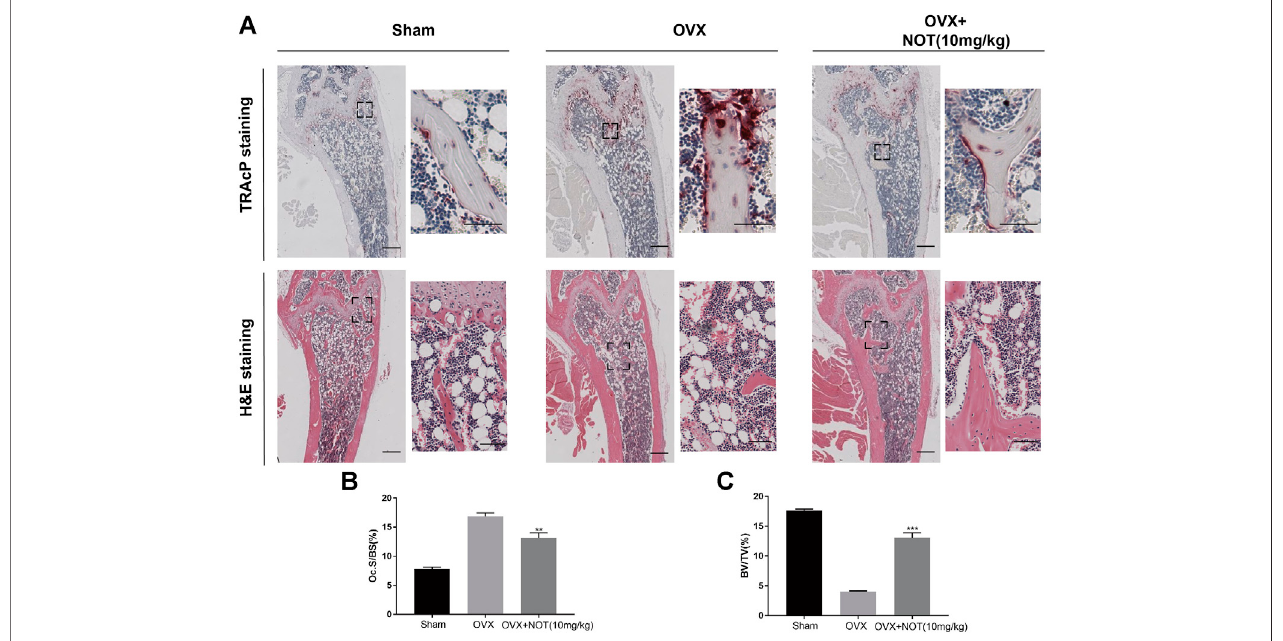
FIGURE 7 | Notopterol ameliorates OVX-induced bone loss by suppressing osteoclast activity. (A) Representative images of decalci fi ed bone stained with TRAcP and H and E in sham-treated, OVX, OVX + Notopterol (10 mg/kg) groups. Scale bar (cid:2) 500 μ m; Scale bar (cid:2) 100 μ m (TRAcP) and Scale bar (cid:2) 200 μ m (H and E) in the enlarge pictures. (B – C) Quantitative analysis of osteoclast surface/bone surface (B) and bone volume/total volume (C) in tissue sections. Dataare presented as mean ± SEM. n (cid:2) 3 per group. Signi fi cant differences between the control and treatment groups are shown as ** p < 0.01 and *** p <